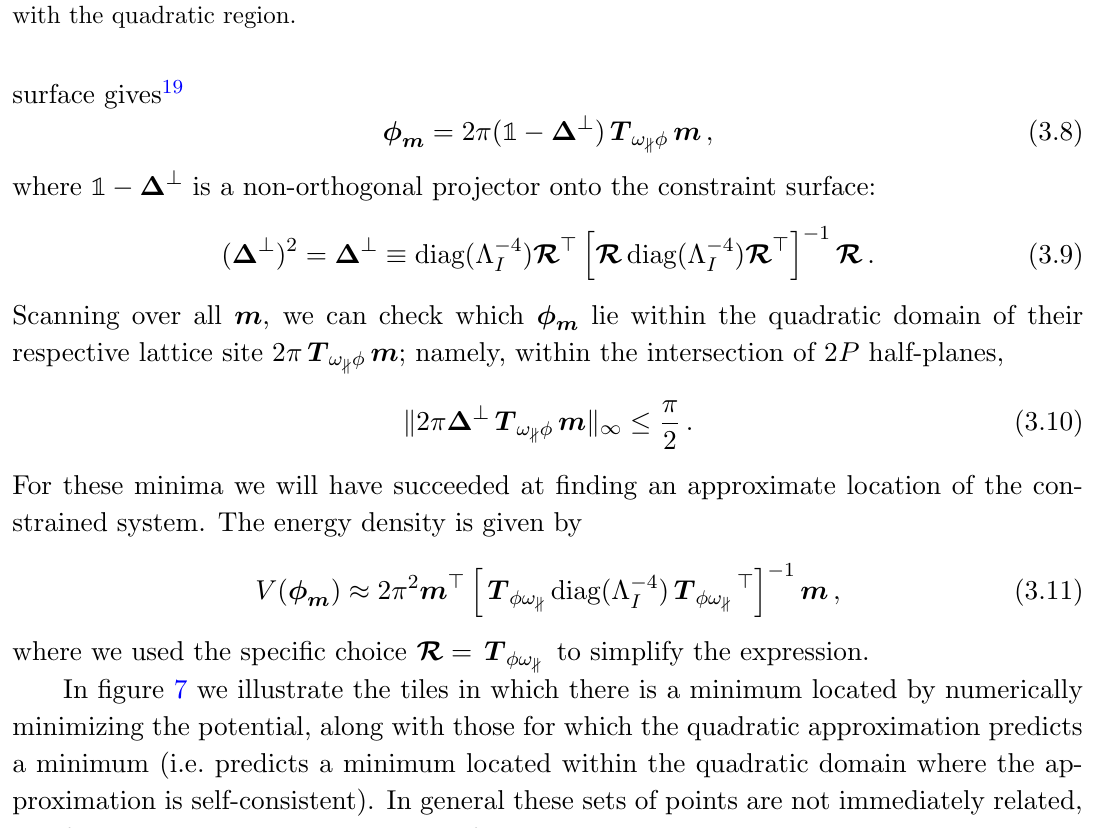
Figure 7 . The blue shaded region illustrates the polytope C in ! lattice points corresponding to distinct tiles for an example with P = N + 2 = 8 (cf. (cid:12)gure 5 where the same region is shown). The central six-sided region is bounded by the 2 P half-planes that determine the validity of the quadratic approximation (3.10). Tiles that contain a minimum as determined by numerical minimization are denoted by blue crosses, and nearly perfectly overlap with the quadratic